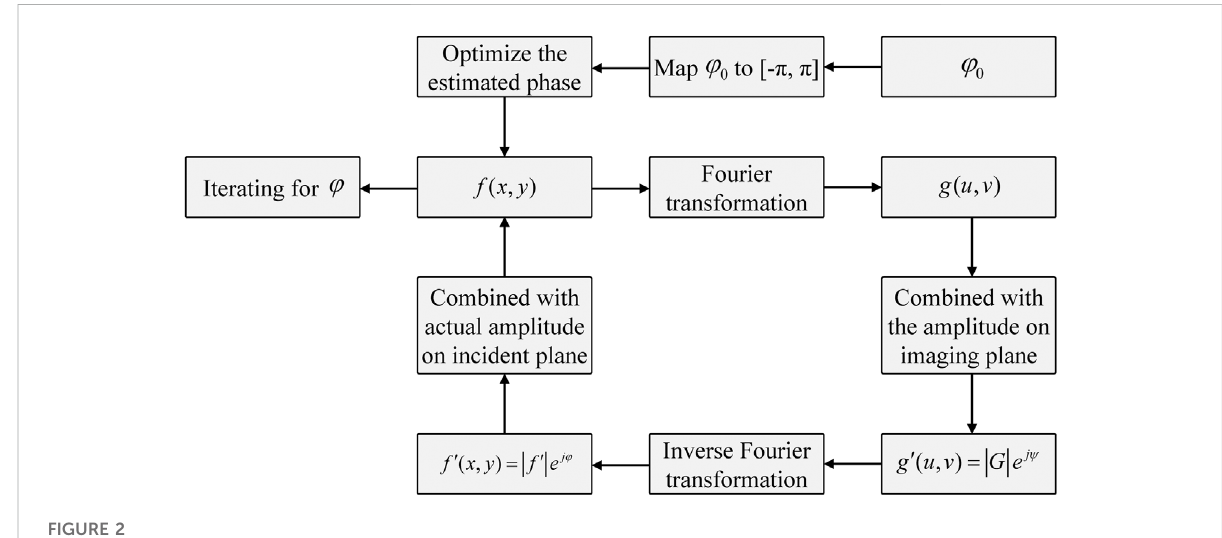
FIGURE 2 Schematic of the improved algorithm calculating steps.